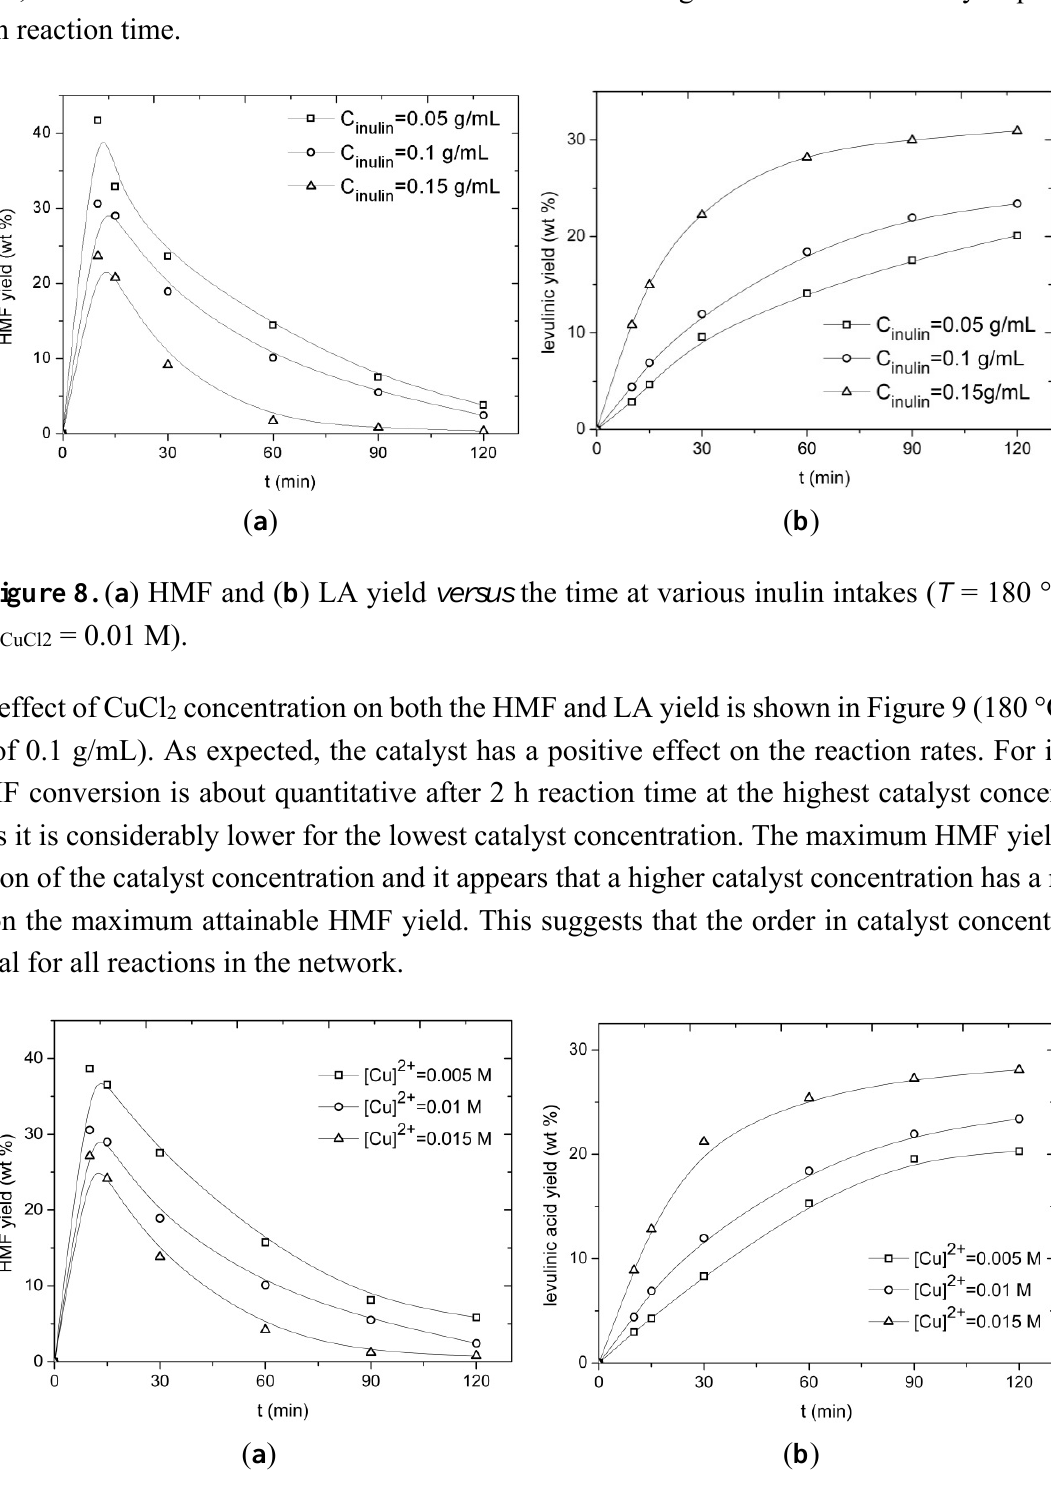
Figure 9. ( a ) HMF and ( b ) LA yield versus the time at various CuCl 2 concentrations ( T = 180 °C, C inulin = 0.1